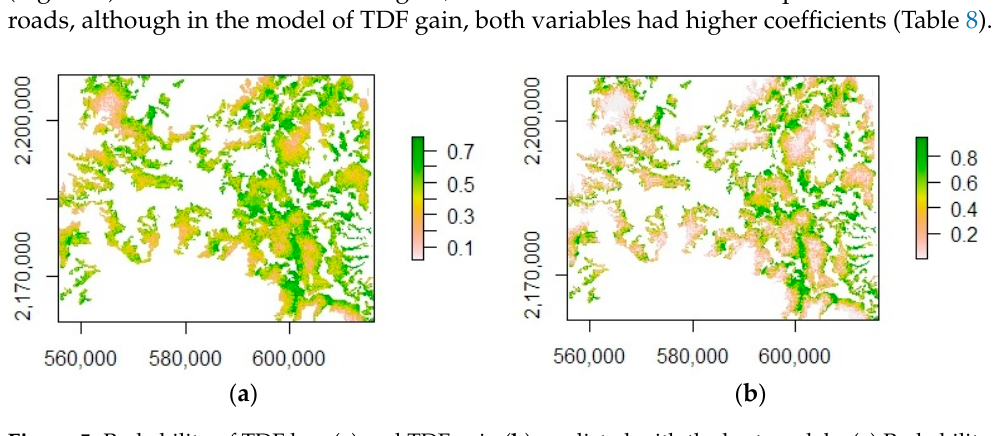
( b ) Figure 6. Boxplots of the patch size (ha) of ( a ) TDF loss patches and ( b ) TDF gain patches. 4. Discussion 4.1. TDF Dynamics During 2019–2022, in our study area, the average TDF loss and TDF gain were esti- mated at 6235 ha and 2784 ha, respectively, and the average rate of TDF loss and TDF gain was estimated at 1.6% and 0.7% per year, respectively. The rate of TDF loss was higher than the national level TDF loss estimated at 0.4% per year by [10], but it was comparable with the annual TDF loss rate of 1.4% at the regional level estimated by [12]. As for TDF gain, we did not find studies at the national or regional level to compare with. Both the